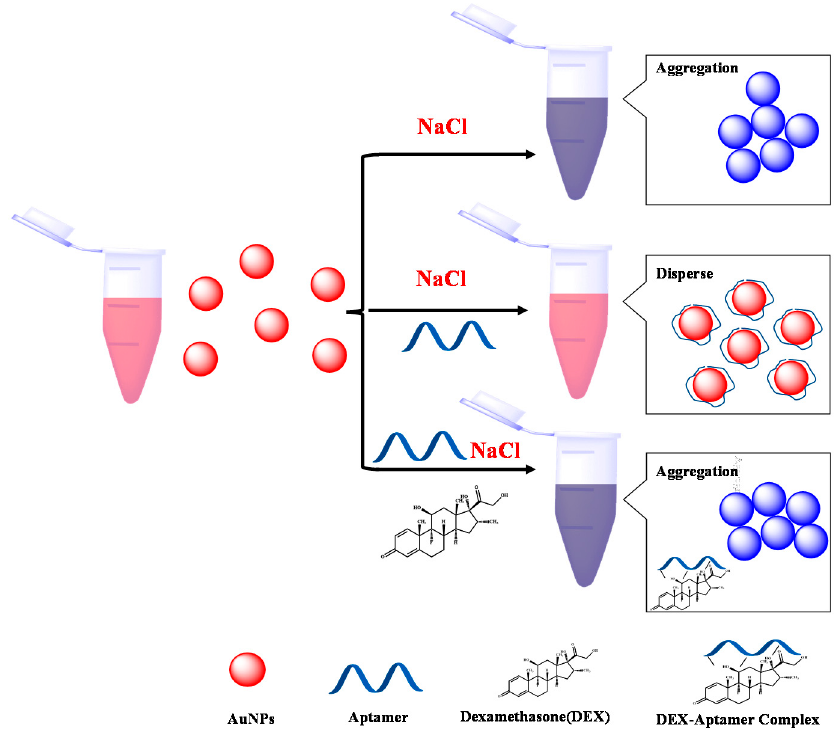
Figure 1. Schematic diagram of the colorimetric method for DEX detection based on aptamers and AuNPs.